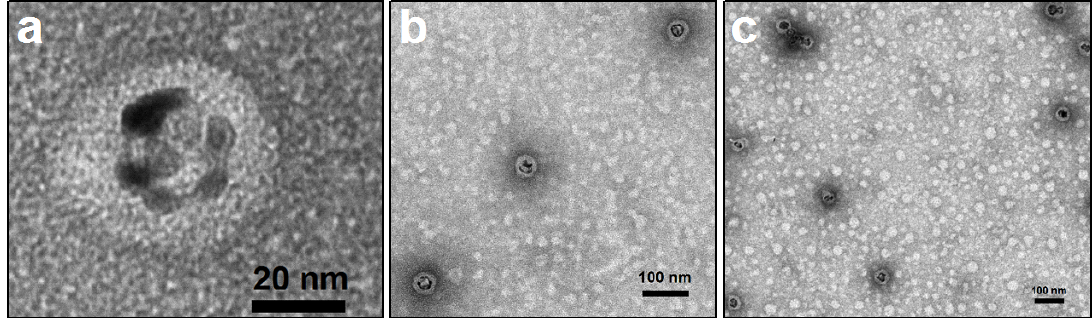
Figure 6. Negative staineded TEM micrographs of AuNSs encapsidated by CCMV CP at pH 4 and I = 0.01 M ( a ) and ( b ) closer look of AuNSs encapsidated with CCMV CP. ( c ) Wider image AuNSs encapsidated with CCMV CP were it can also be seen empty capsids (clearer spheres with no core).